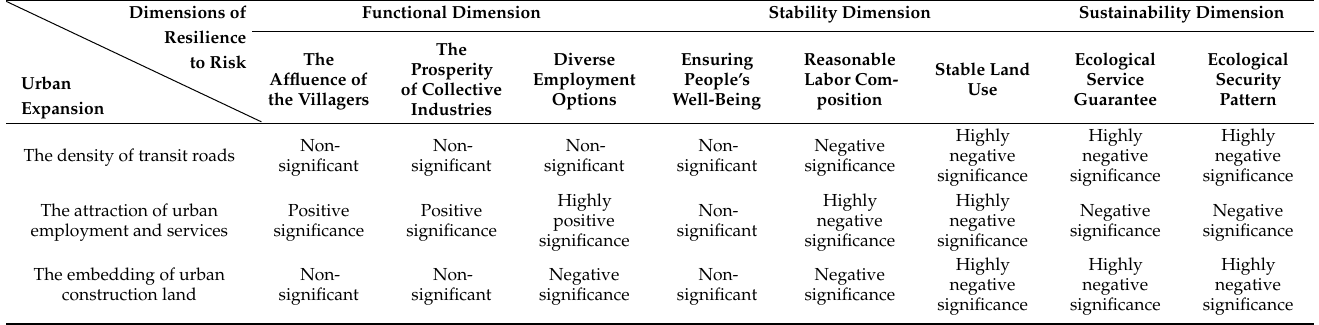
Table 7. Statistical analysis of the impact of urban expansion on spatial differentiation of rural resilience to